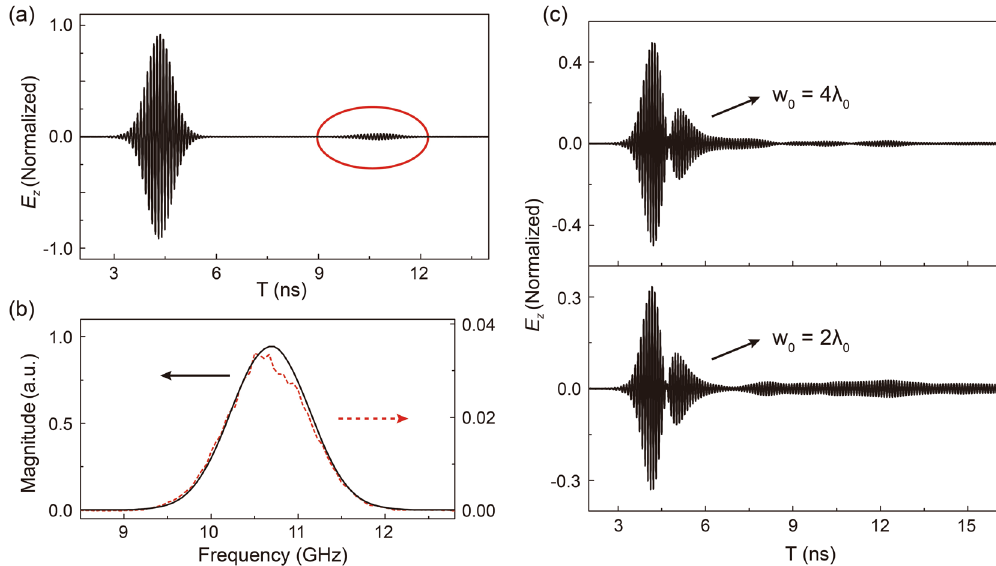
Figure 4. ( a ) Simulated temporal transmission spectra with plane wavefront. The second pulse due to multiple reflection in PC is encircled in red. ( b ) The spectra of the first (solid line) and the second pulse (dashed line). ( c ) The profiles of transmitted pulse through the sample with different transverse spatial half-widths.